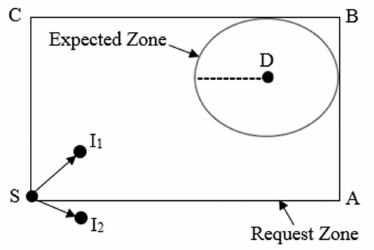
Figure 4. The request zone.